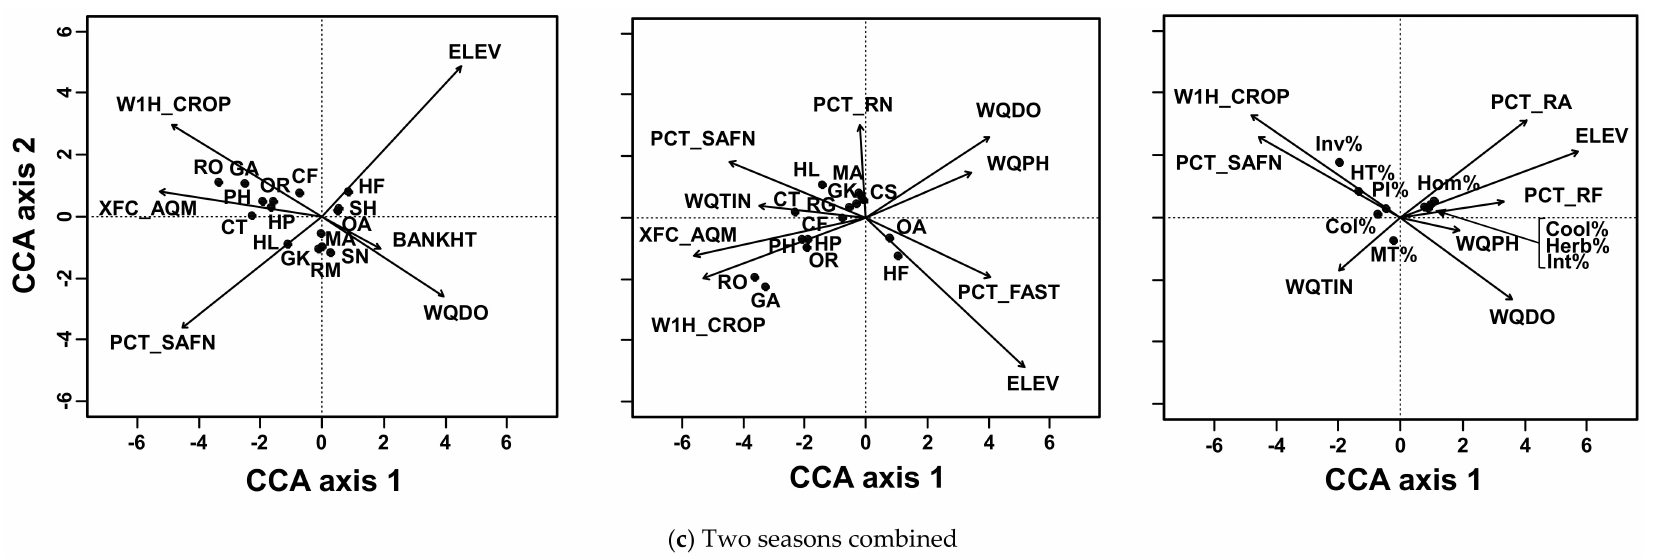
Figure 3. CCA biplots of three fish measures of three seasonal data. ( a ) The pre-typhoon season, ( b ) the post-typhoon season, and ( c ) the two seasons combined represented as CCA biplots with corresponding presence–absence, abundance, and community characteristics data. Descriptions of abbreviations of habitat variables are in Table 2, and explanations of abbreviations of fish are in Tables 1 and